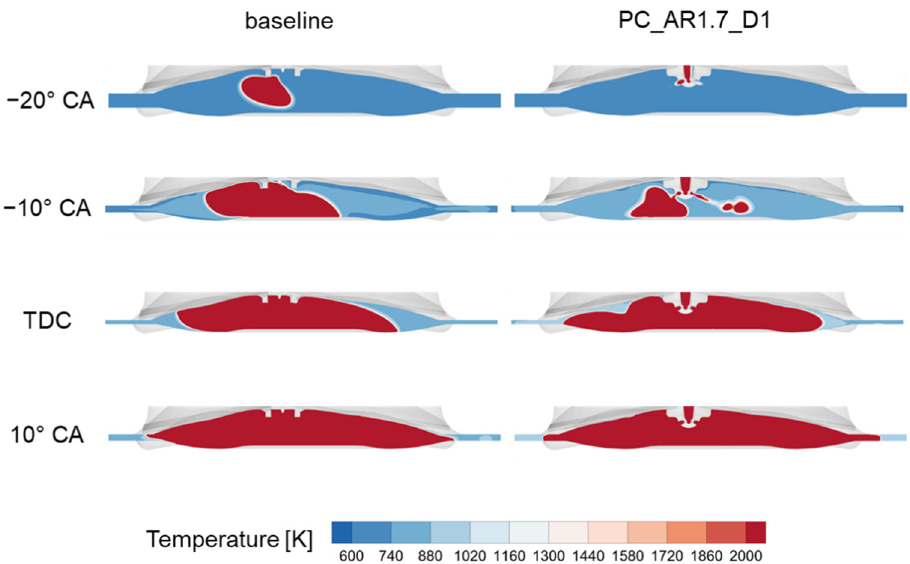
Figure 10. Flame front propagation: comparison between standard engine and pre-chamber en- gine.